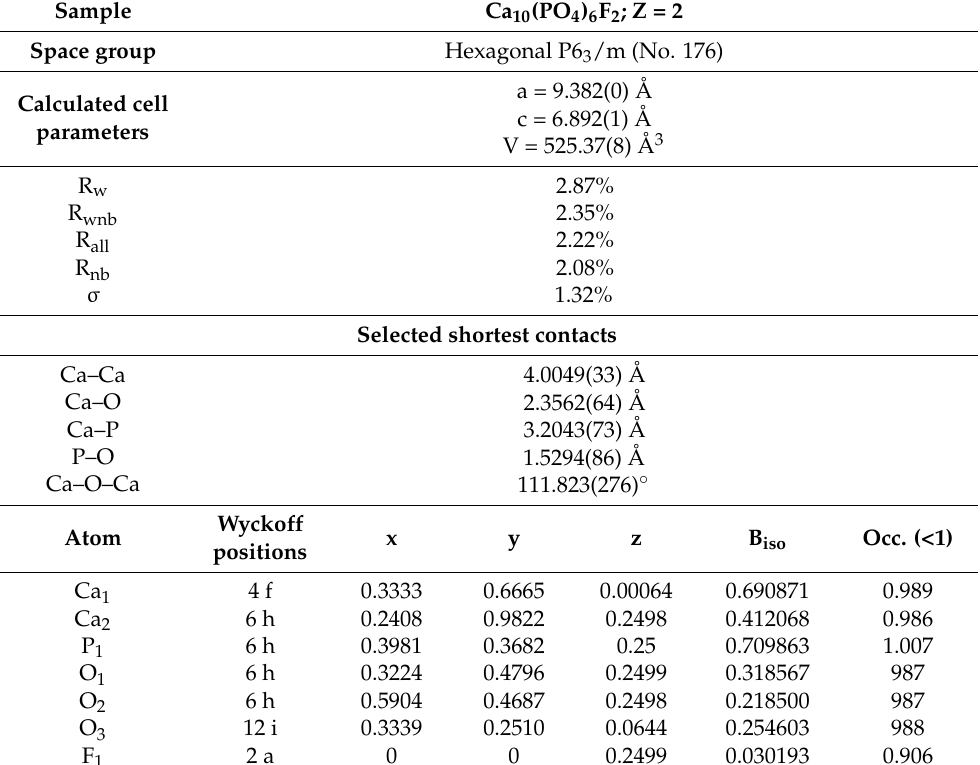
Table 1. Atomic parameters of the Ca 10 (PO 4 ) 6 F 2